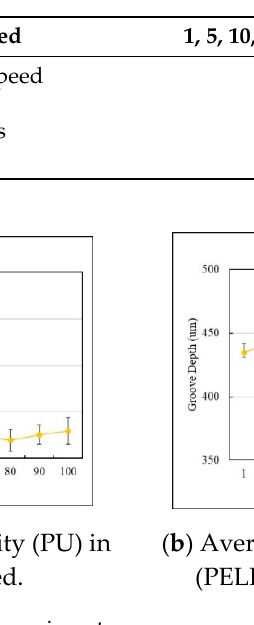
Table 5. Parameters of metrological experiments.